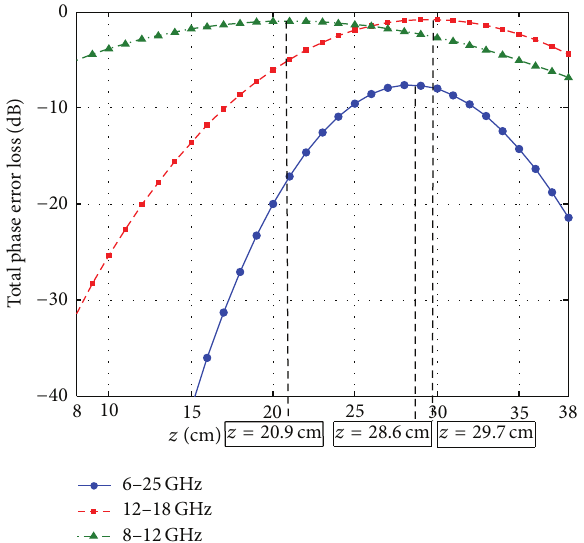
Figure 9: Total PEL variations with 𝑧 parameter.